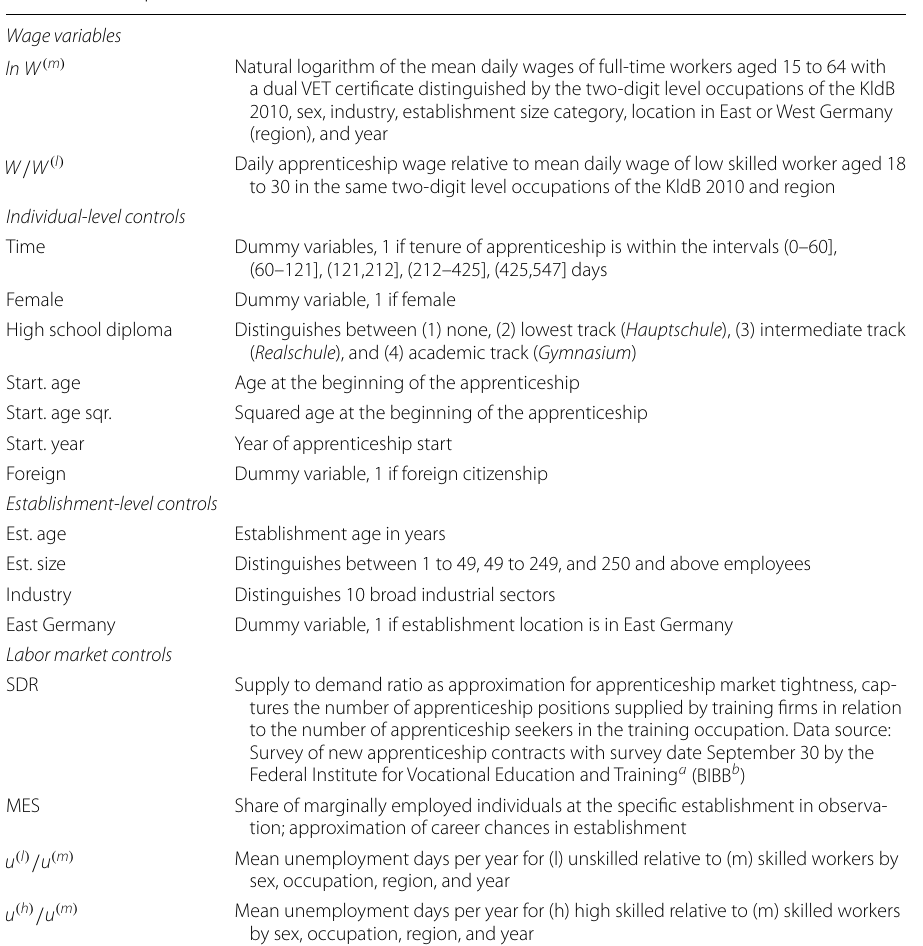
Table 1 Description of the model